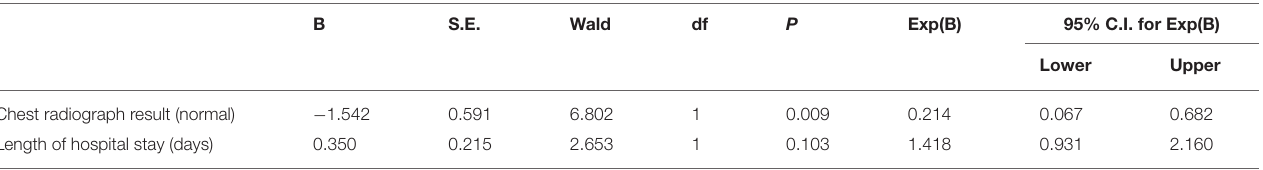
TABLE 3 | Multiple logistic regression of using antibiotics (“yes”) vs. predictors listed in the footnote, using backward selection (likelihood ratio); P -value for the model is 0.001. B S.E. Wald df P Exp(B) 95% C.I. for Exp(B)